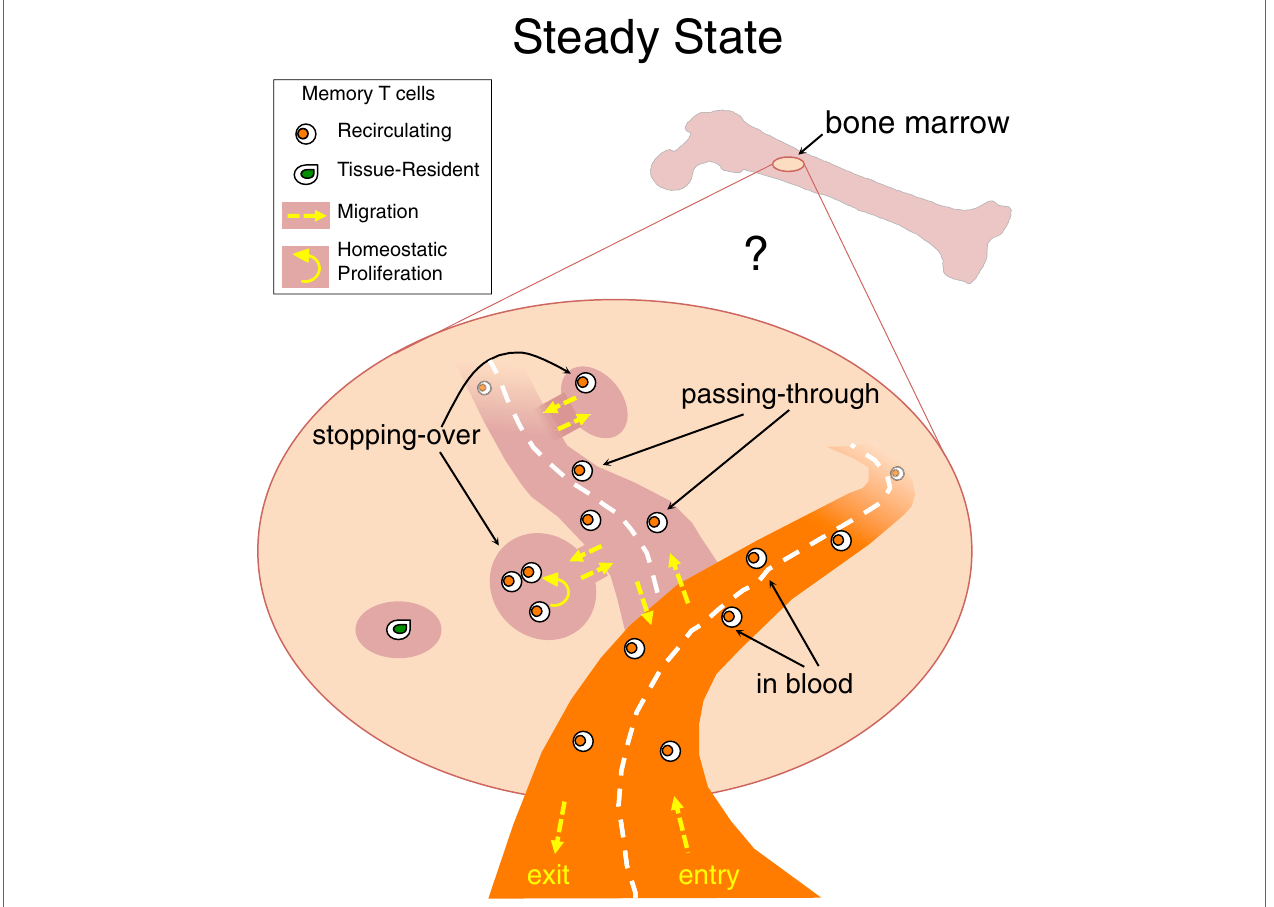
FiGURe 2 | Stopping-over, passing-through and tissue-resident memory T cells in bone marrow . Under steady state, memory T cells migrate into the BM and then circulate back to the blood, with poorly defined kinetics. It is possible that some recirculating memory T cells quickly transit through the BM parenchyma while others stop over for some time within BM niches. A few memory T cells might stay permanently in BM niches and never return to the blood, representing the equivalent of tissue-resident memory (TRM) T cells identified in other